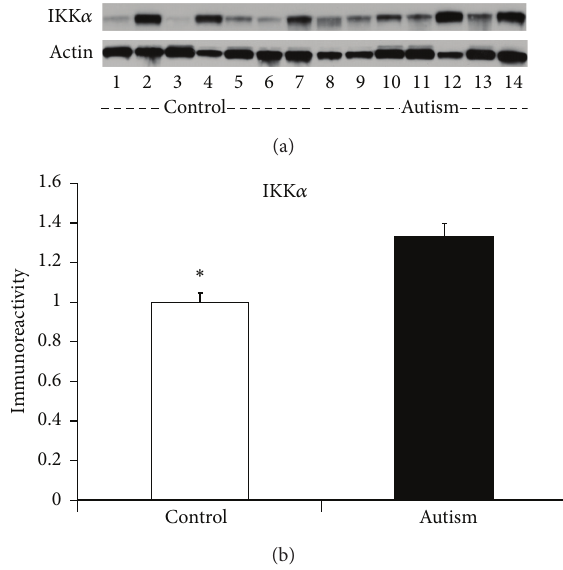
Figure 1: IKK 𝛼 protein expression in the cerebellum of autistic subjects. (a) Western blot studies on cerebellar homogenates using IKK 𝛼 antibody (dilution 1: 1000). Lanes 1–7 represent control subjects and lanes 8–14 represent autistic subjects. (b) The blots shown in (a) were quantitated after being normalized by actin. Data are shown as mean ± SE. ∗ 𝑃 < 0.05 versus control